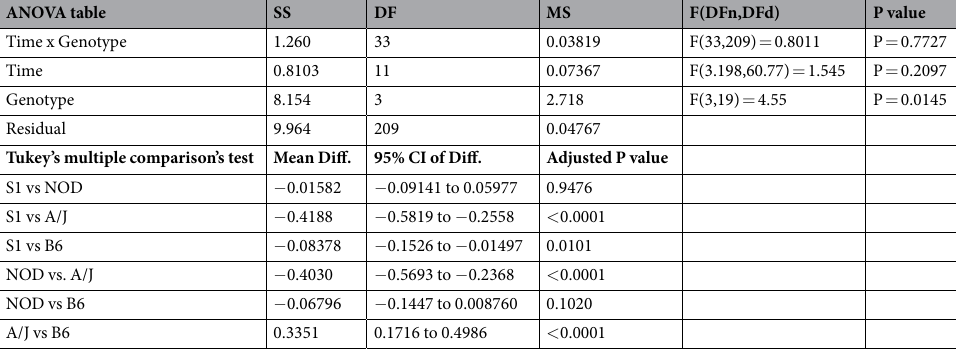
Table 1. Statistical table describing the 2-way ANOVA output and the multiple comparisons made in Fig. 1, panel A, between mouse strains during chow food intake.